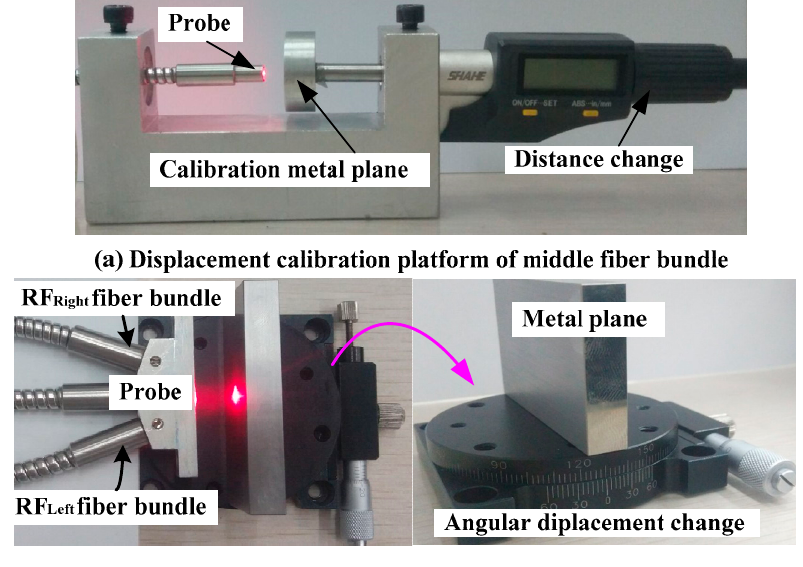
Figure 14. Sensor static calibration station.